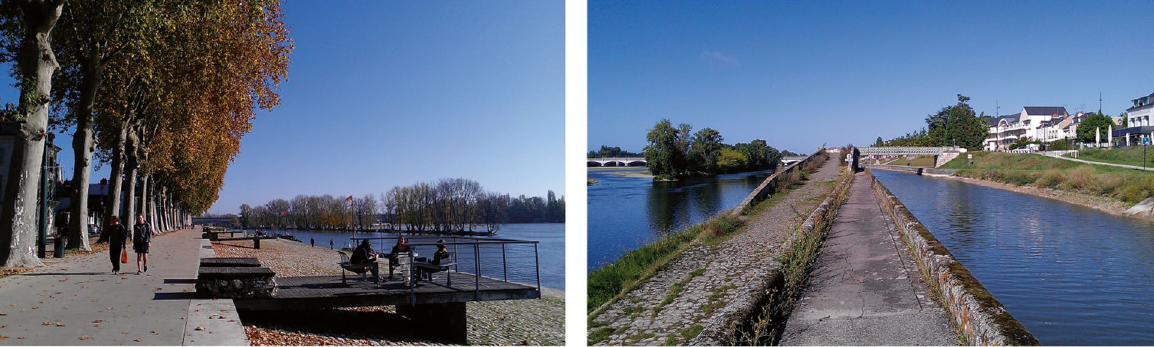
Fig. 13 Top and bottom images on the right: The riverbank and canal of Orléans after the restoration and rehabilitation project, 2017 (Source: Liang